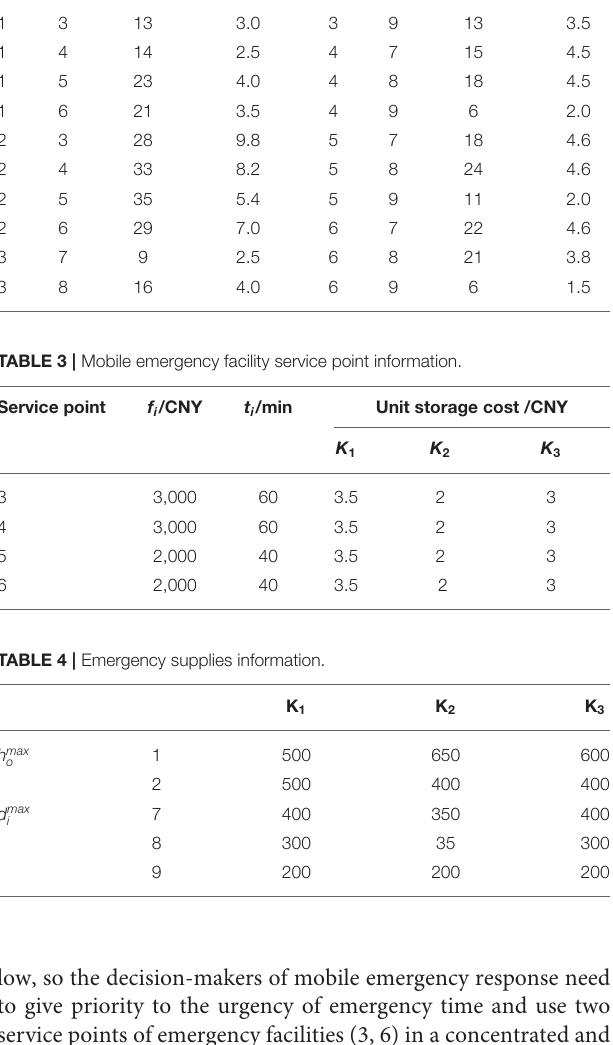
TABLE 5 | Optimal emergency plan under different cost preference degrees. α Participating service